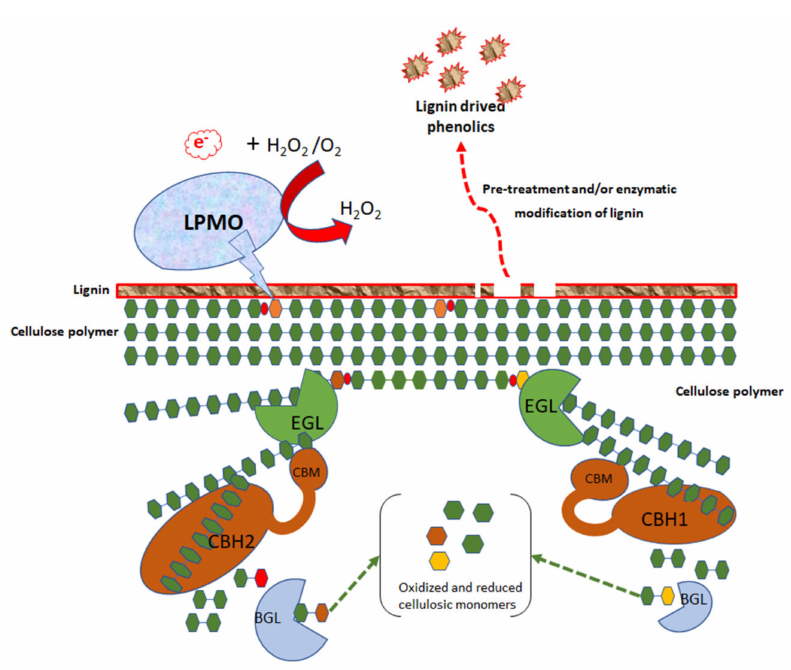
Figure 1. Action of biocatalysts on cellulose polymer to hydrolyse into its monomers.